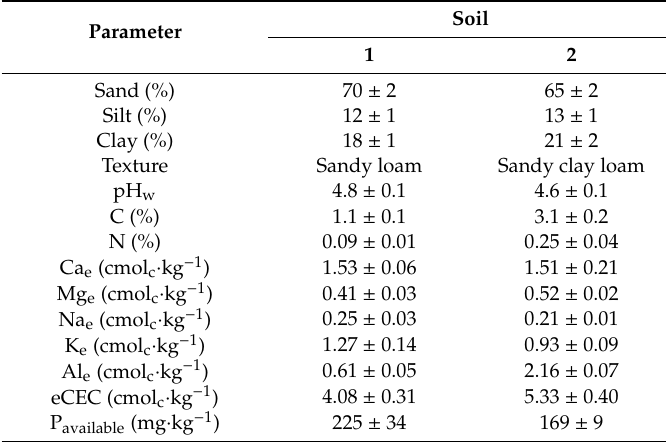
Table 1. General characteristics of the soils